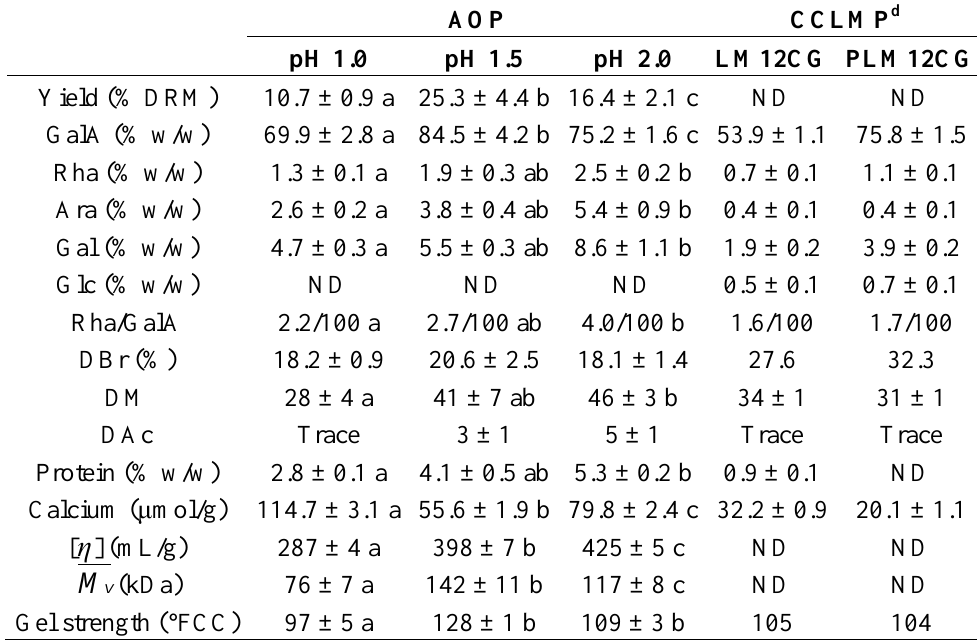
Table 1. Glycosyl residue composition, macromolecular features, and gelling capability of acid-extracted pectins from cashew apple